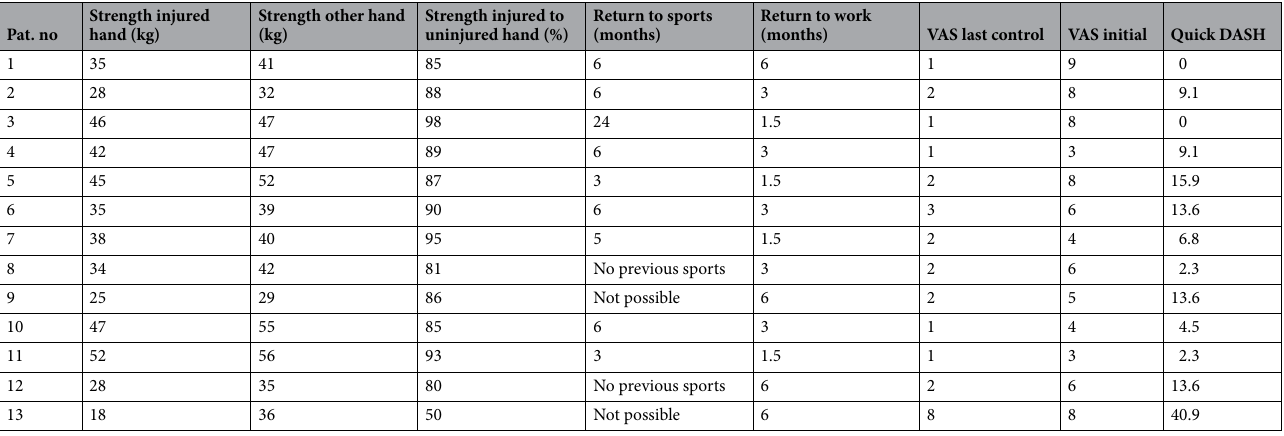
Table 3. Results of the follow-up